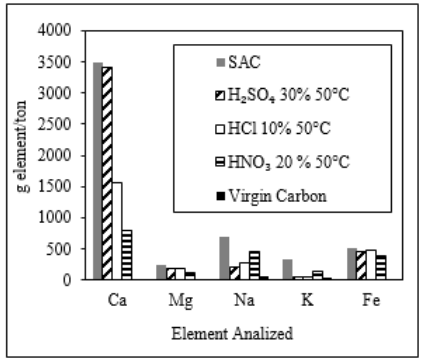
Figure 2. Content of Ca, Mg, Na, K, and Fe (g/ton) for reactivated carbons subjected to chemical reactivation at 50 °C with HCl (10% v / v ), HNO 3 (20% v / v ), and H 2 SO 4 (30% v / v ), respectively. The content of these elements (Ca, Mg, Na, K, and Fe) is shown as well for virgin carbon and SAC.